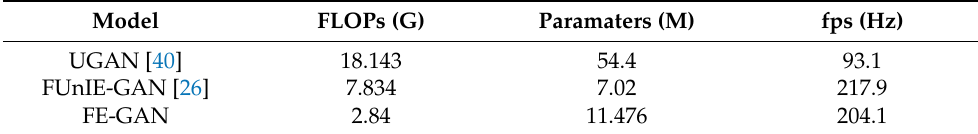
Table 5. Real-time comparison results with UGAN and FUnIE-GAN.